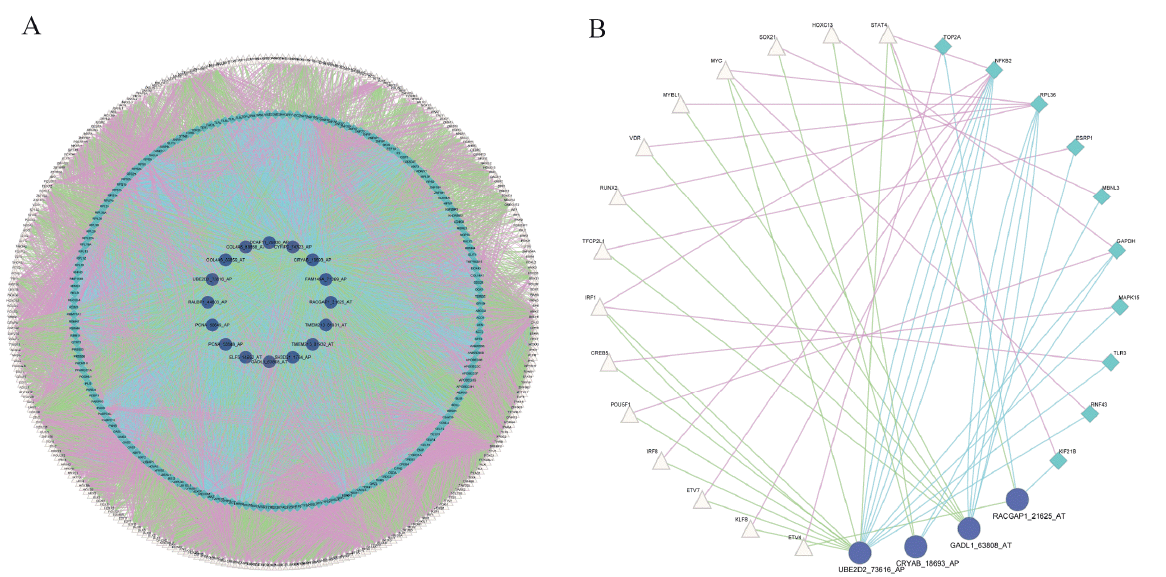
Figure 3. Construction of protein–protein interaction network of triplets. ( A ) Protein–protein interaction network of 6519 triplets. Pink triangles represent TFs, green rhombuses represent RBPs, purple circles represent ASEs. Purple lines represent relationships between TF and RBP genes, green lines represent relationships between TF genes and ASEs, and blue lines represent the relationships between RBP genes and ASEs. ( B ) Triplet network involved in known PPI network in STRING.